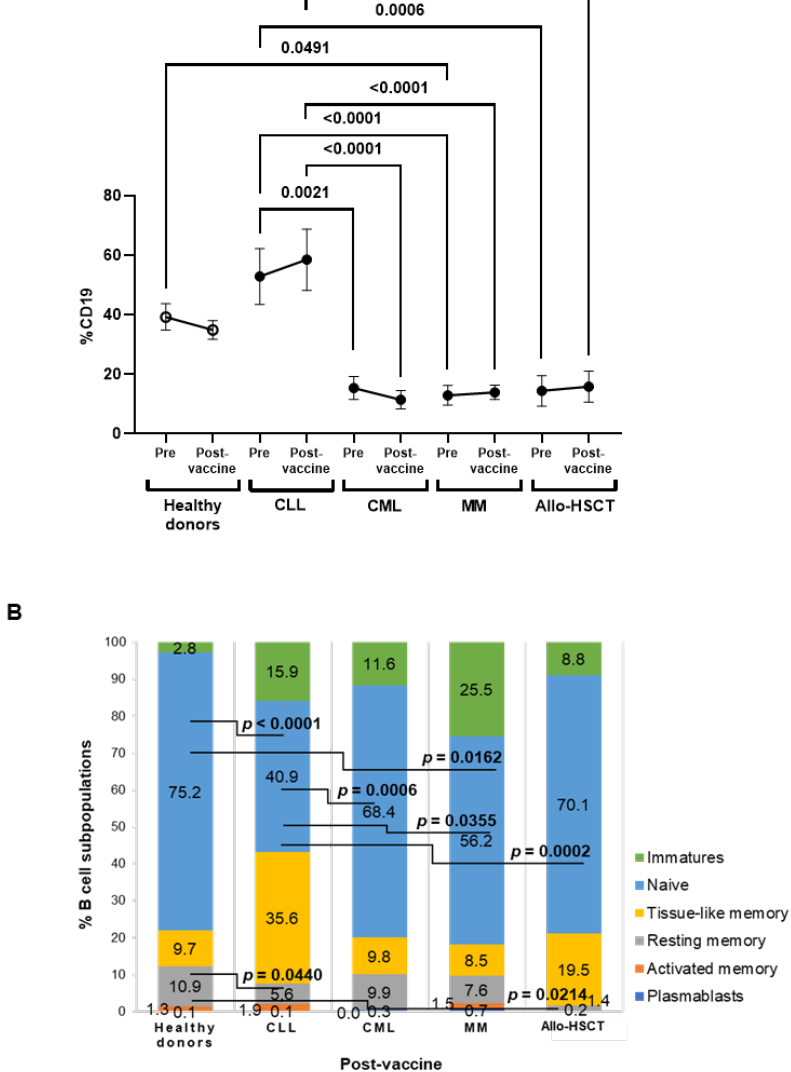
Figure 2. Total levels and subpopulations of B cells in PBMCs of individuals with OHD before and after receiving one-dose vaccine against SARS-CoV-2. ( A ) Total B cell levels in peripheral blood mononuclear cells (PBMCs) of individuals with chronic lymphocytic leukemia (CLL), chronic myeloid leukemia (CML), multiple myeloma (MM), or allogeneic stem cell transplant (Allo-HSCT) before and after receiving the first dose of SARS-CoV-2 vaccine, in comparison with healthy donors. Each dot in the graphs corresponds to mean ± SEM. ( B ) Analysis of B cells subpopulations after receiving one dose of SARS-CoV-2 vaccine in these cohorts. Mean data are represented in bar graphs. Statistical significance between groups was calculated using one-way ANOVA test.